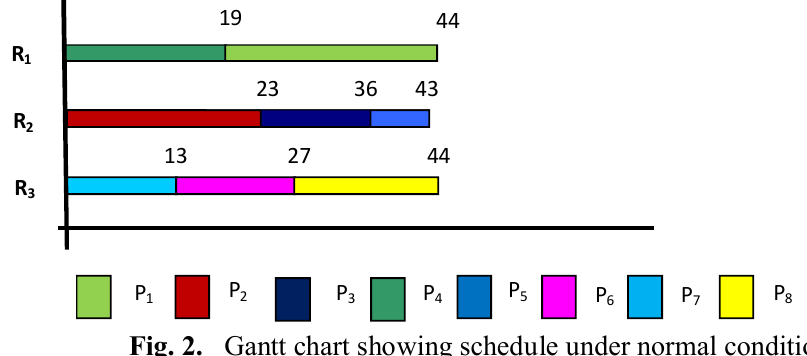
Fig. 2. Gantt chart showing schedule under normal